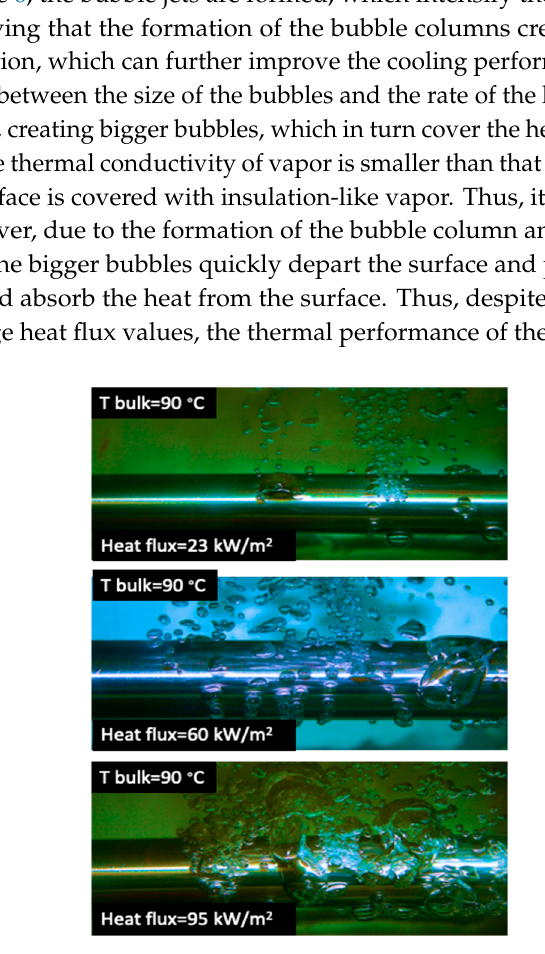
Figure 6. Visualization of the bubble formation inside the annulus pipe at various heat fluxes and for water with TDS value of 1200 mg/L.